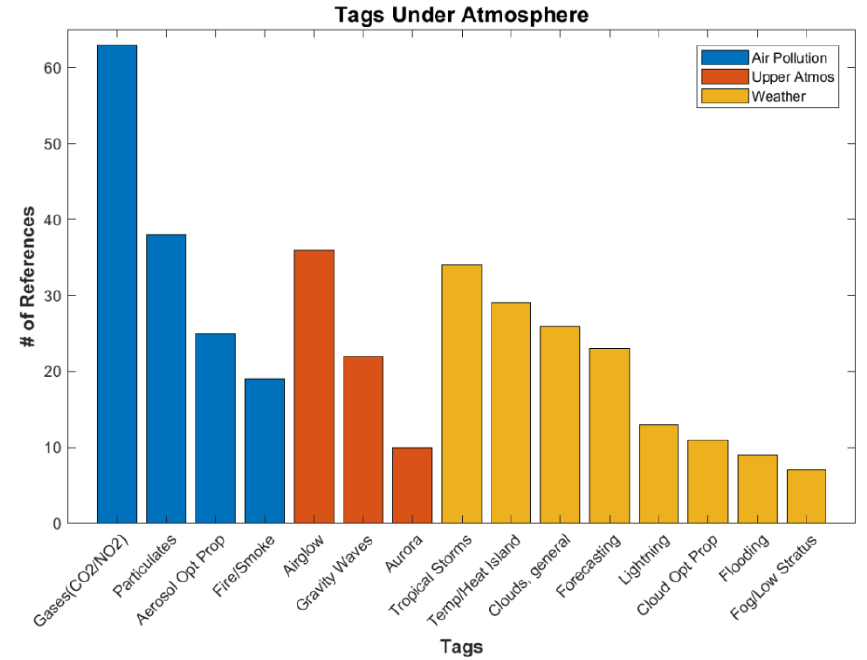
Figure 8. Number of references for various tags under Applications/Atmosphere.